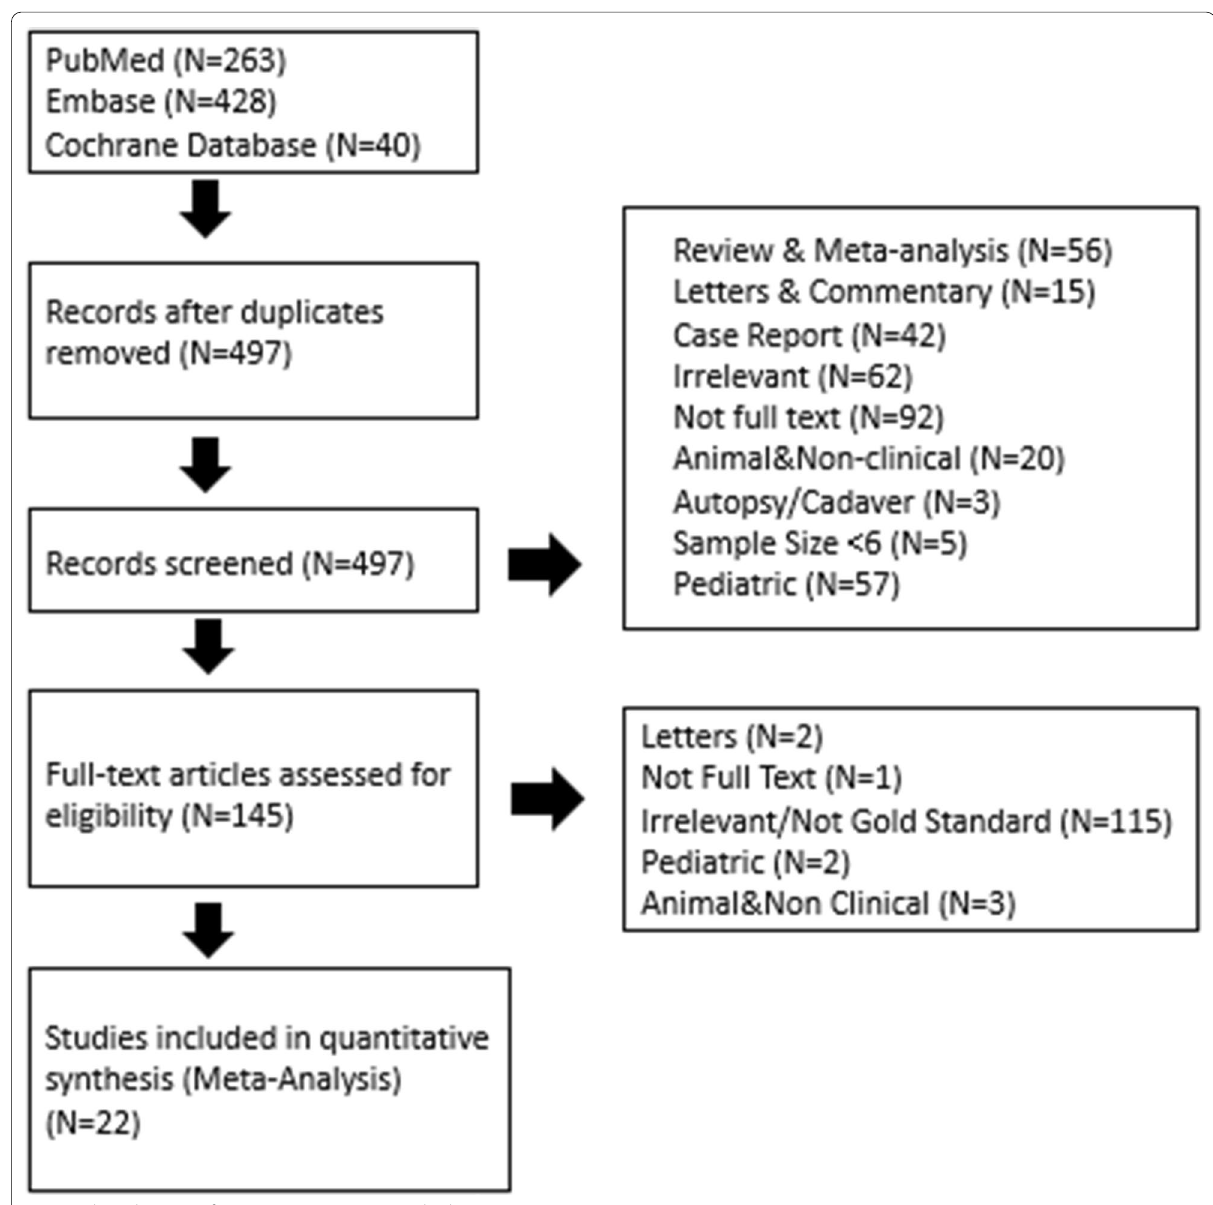
Fig. 1 Flow-diagram of manuscript screening and